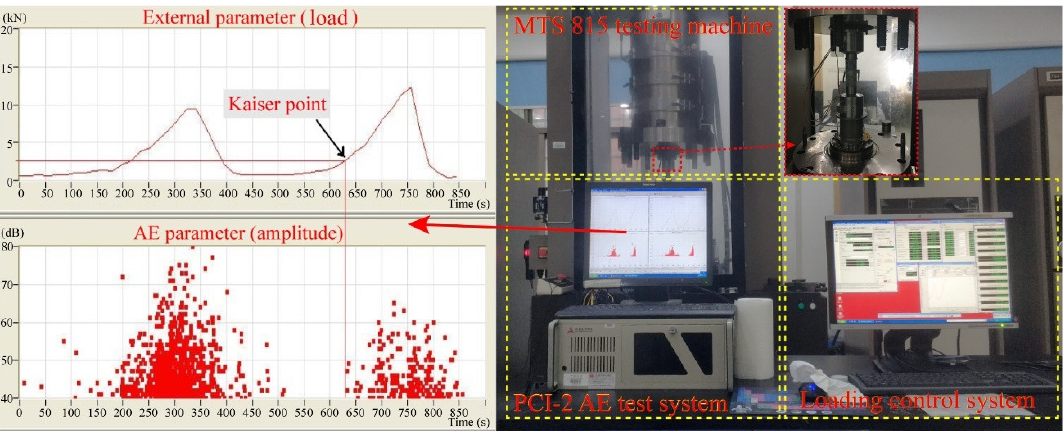
Figure 7. Test equipment and AE test data.